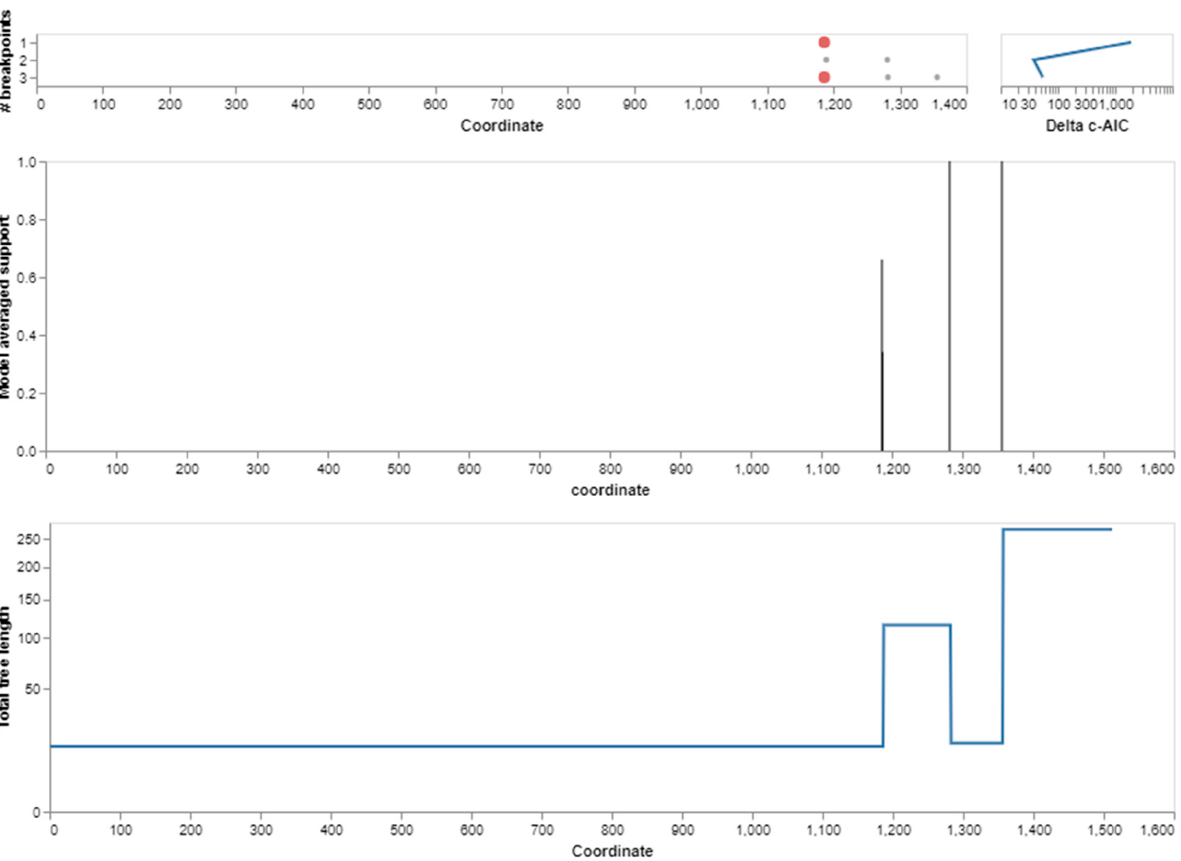
Figure 5. Breakpoints detected in the BPIFA1 gene during evolution. The location of breakpoints, as determined by the algorithm, for each of the different numbers of breakpoints that were taken into consideration. The progression of the c-AIC score from one set of breakpoint numbers to the next (log scale).